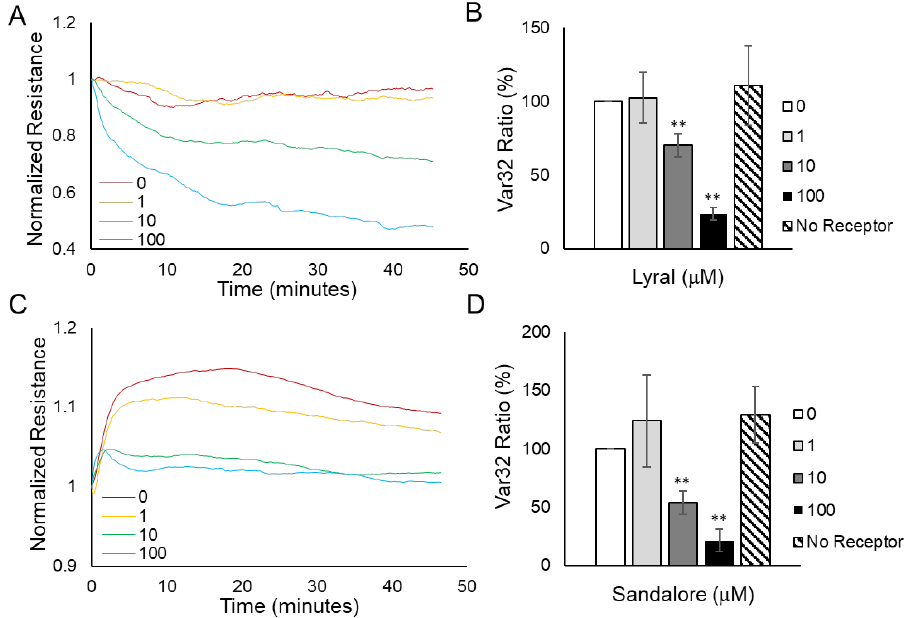
Figure 6. Odorant exposure causes a dose-dependent decrease in cellular micromotion. HUVEC monolayer ( A ) and HaCaT monolayer ( C ) resistance data obtained every second after various concentrations of odorants were added. Var32 analysis of ( B ) HUVEC normalized resistance data 30 min after lyral addition or ( D ) HaCaT normalized resistance data 30 min after Sandalore addition. The average Var32 for each treatment well was normalized to the control well tested at the same time, and at least three independent experiments were performed and averaged together to represent the Var32 ratio (%) presented as mean ± SEM. The analysis shows a significant decrease in the micromotion of both HUVEC and HaCaT monolayers after 10 or 100 µ M of lyral or Sandalore, respectively, was added. As an additional negative control, a 100 µ M dose of the odorant was added to a cell monolayer that did not express the corresponding receptor (no receptor) and no significant decrease in micromotion was observed. A two-tailed t -test was performed to compare each odorant-treated group to the control; ** p < 0.01 as